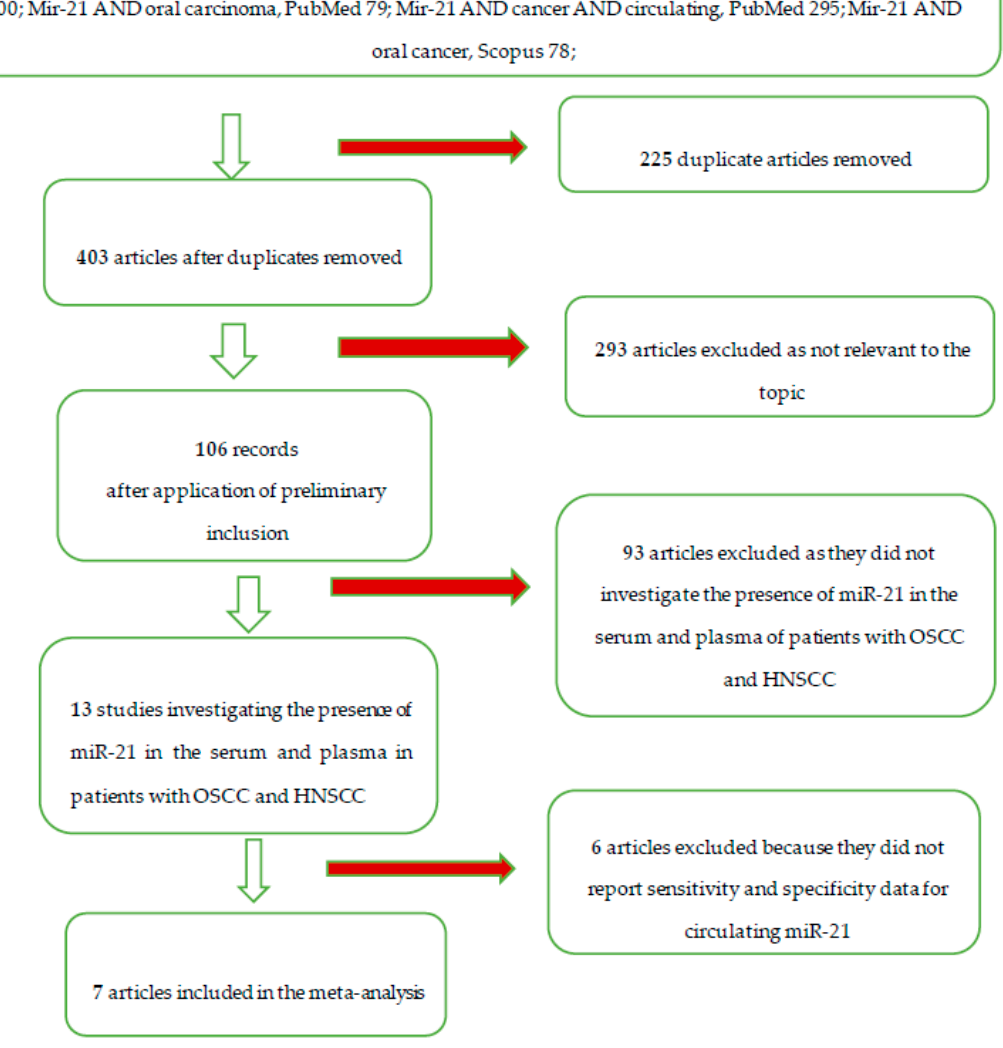
Figure 1. Flow chart of the different phases of the systematic review. From a total of 628 records, we ended up with 13 clinical studies investigating miR-21 in patients with HNSCC, and 6 articles that assessed sensitivity and specificity by satisfying the inclusion criteria.